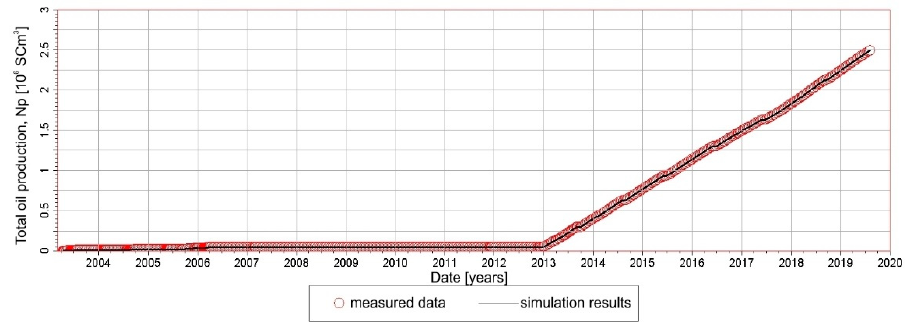
Figure 10. Total reservoir gas production.